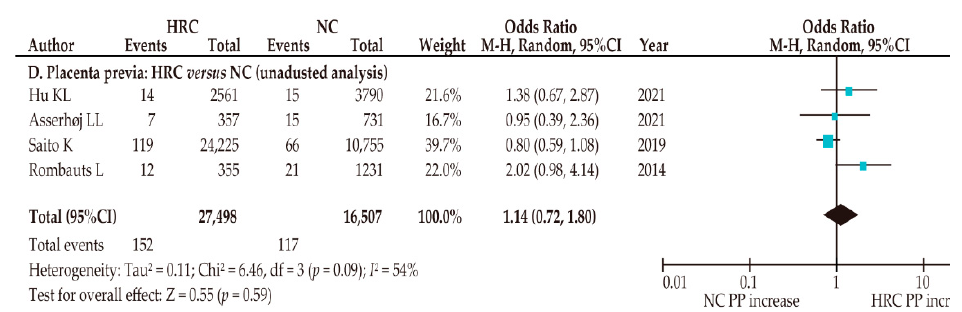
Figure 4. Effect of assisted reproductive technology on the prevalence of placenta previa (sensitivity analysis). All analyses were performed using an unadjusted analysis. All analyses compared the rates of placenta previa of the examination and control groups. The pooled odds ratios (ORs) for the comparisons were determined for the following groups: ( A ) ART with endometriosis versus ART without endometriosis; ( B ) women with endometriosis who conceived using ART versus women with endometriosis who conceived spontaneously; ( C ) frozen embryo transfer (ET) versus fresh ET; and ( D ) hormone replacement cycle (HRC) versus normal cycle (NC). Forest plots were ordered within the stratum by relative weight (%) and the publication year of the study. Substantial heterogeneity was observed during analysis ( A ) ( I 2 = 73%), moderate heterogeneity was observed during analysis ( C ) ( I 2 = 52%), and considerable heterogeneity was detected during analysis ( C ) ( I 2 = 54%). Some values might be slightly different from the original values, because calculations were performed using RevMan ver. 5.4.1. Abbreviations: ART, assisted reproductive technology; OR, odds ratio; CI, confidence interval; SE, standard error; PP, placenta previa; ART_end, endometriosis who conceived using ART; SC_end, endometriosis who conceived spontaneously; Frozen, frozen embryo transfer; Fresh, fresh embryo transfer.